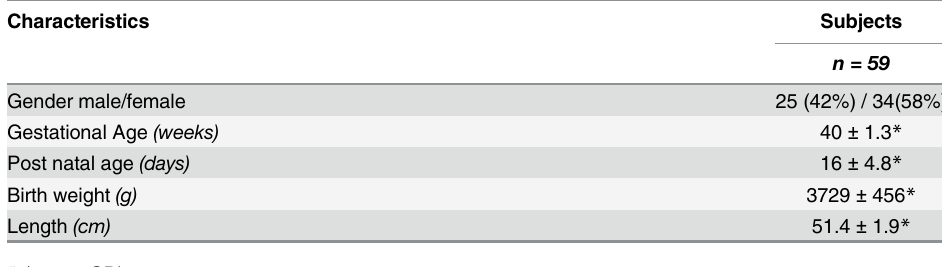
Table 1. Baseline Characteristics of the